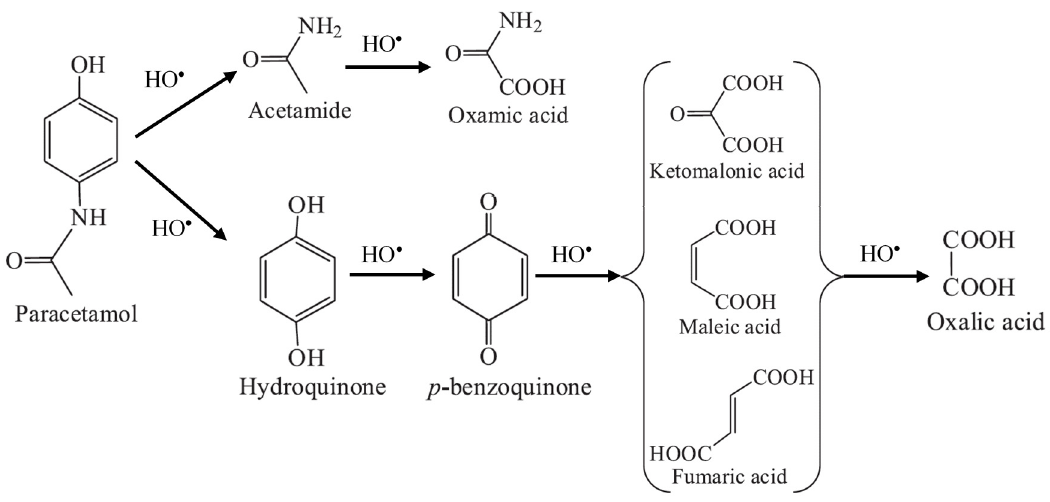
Figure 3. Proposed reaction sequence for paracetamol degradation in acidic aqueous medium by hydroxyl radicals oxidation processes [30]. In our study, we have considered the hydroxyl radical mediated oxidation of paracetamol into oxalic and oxamic acids.